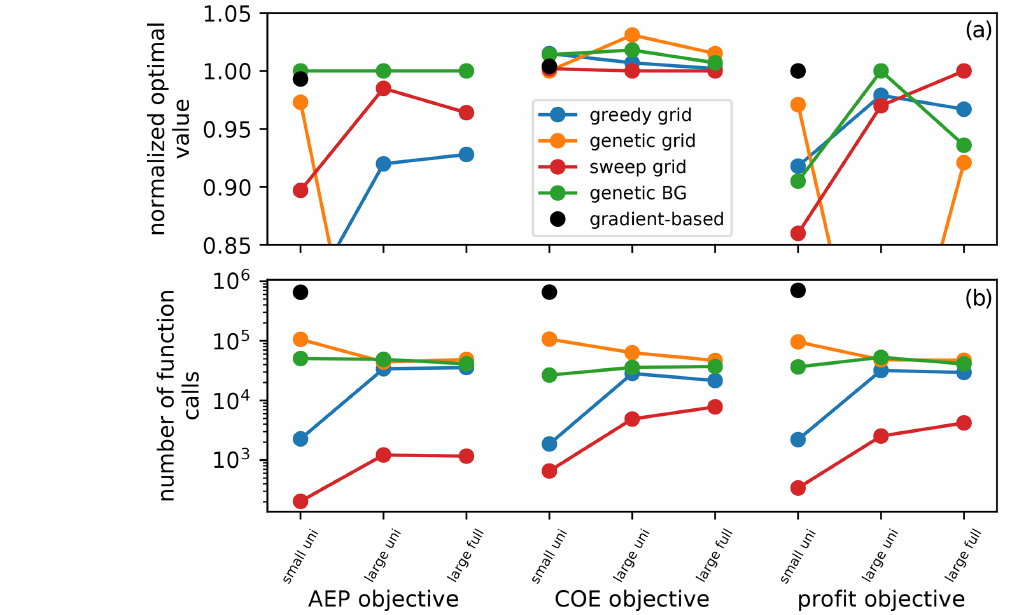
Figure 14. Overall performance representations of the different optimization algorithms. The different colors represent the different opti- mization methods. The top figure shows the best solution quality, and the bottom figure shows the number of function calls required.